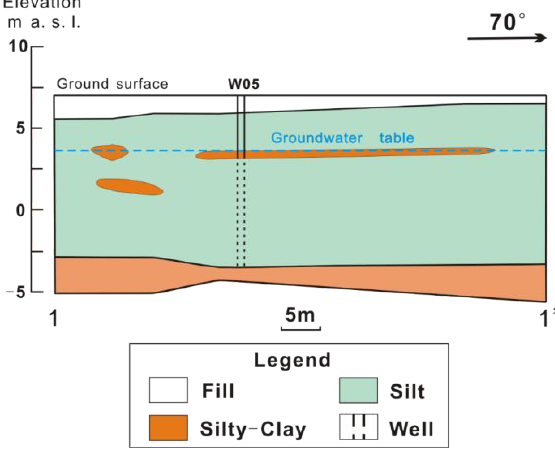
Figure 2. Hydrogeological cross section (1–1’) of the study site.